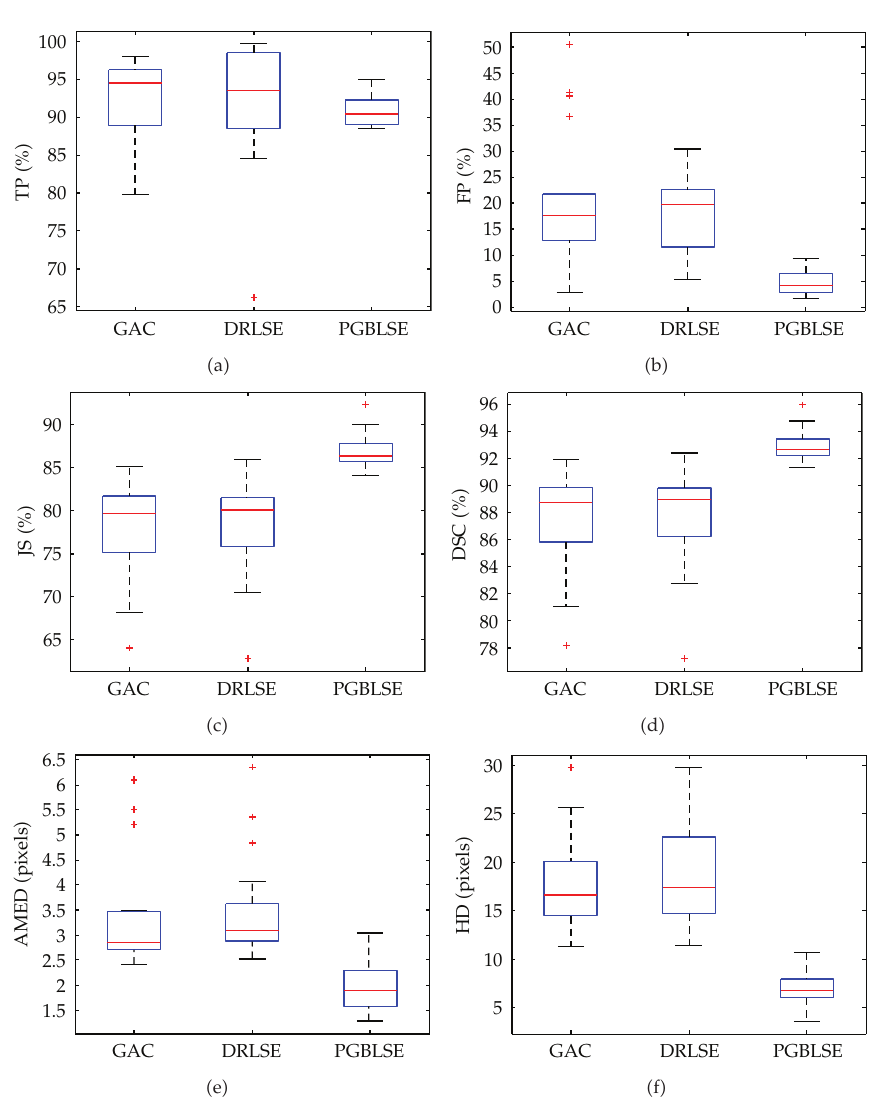
Figure 12: Box plots of segmentation errors among the GAC, DRLSE, and PGBLSE models on 20 clinical US images of breast tumors. (cid:3) a (cid:4) TP, (cid:3) b (cid:4) FP, (cid:3) c (cid:4) JS, (cid:3) d (cid:4) DSC, (cid:3) e (cid:4) AMED, and (cid:3) f (cid:4)